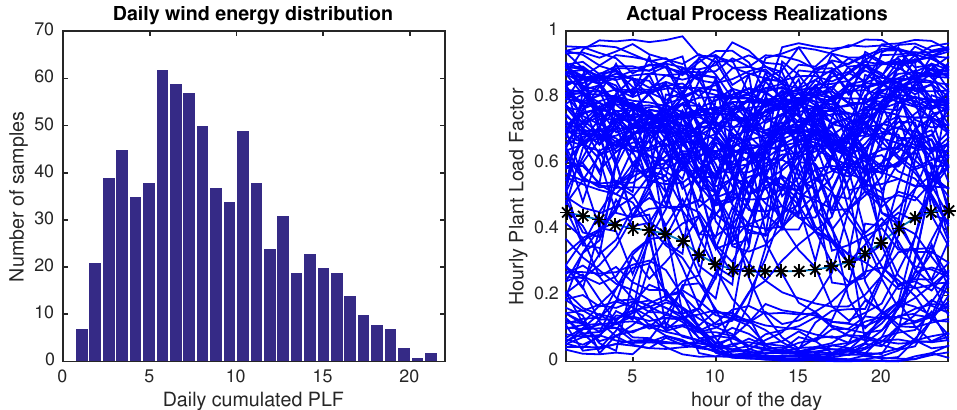
Figure 4. Histogram of daily wind energy samples [daily PLF upon the leftmost] and 30% most atypical realizations for Uruguayan wind-power over a year